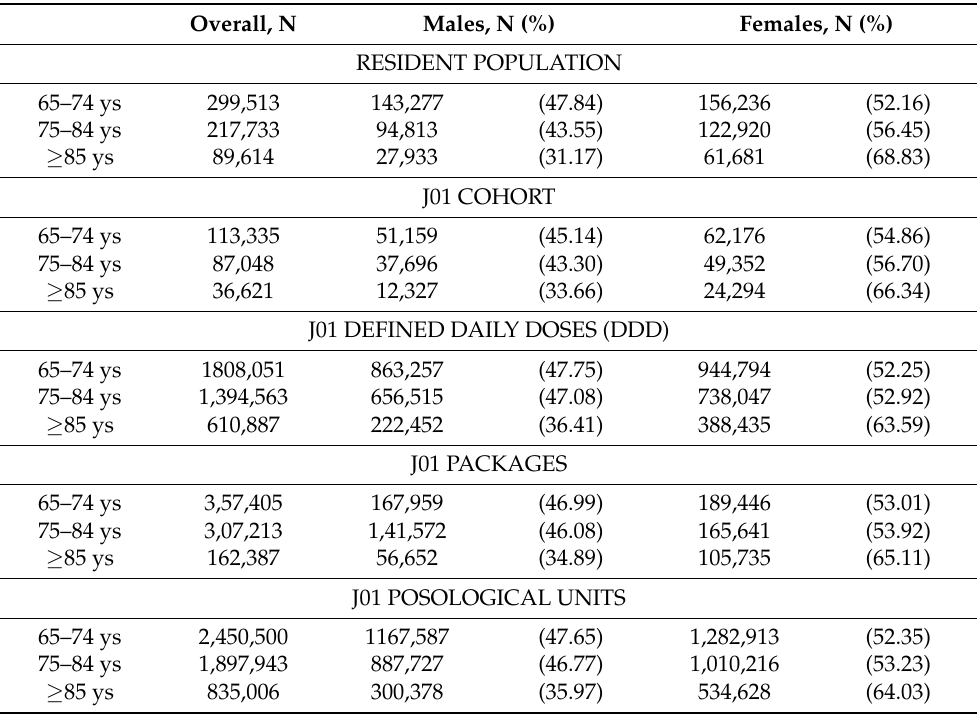
Table 1. Cohort characteristics, by sex and age